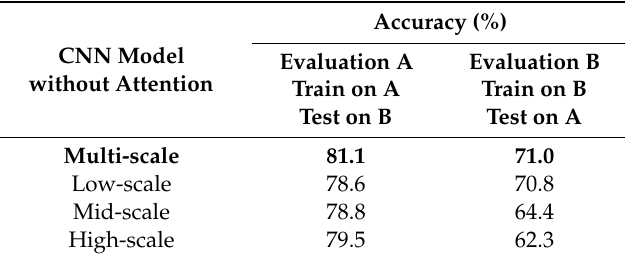
Table 2. Prediction accuracy of multi-scale CNN and single CNN model.